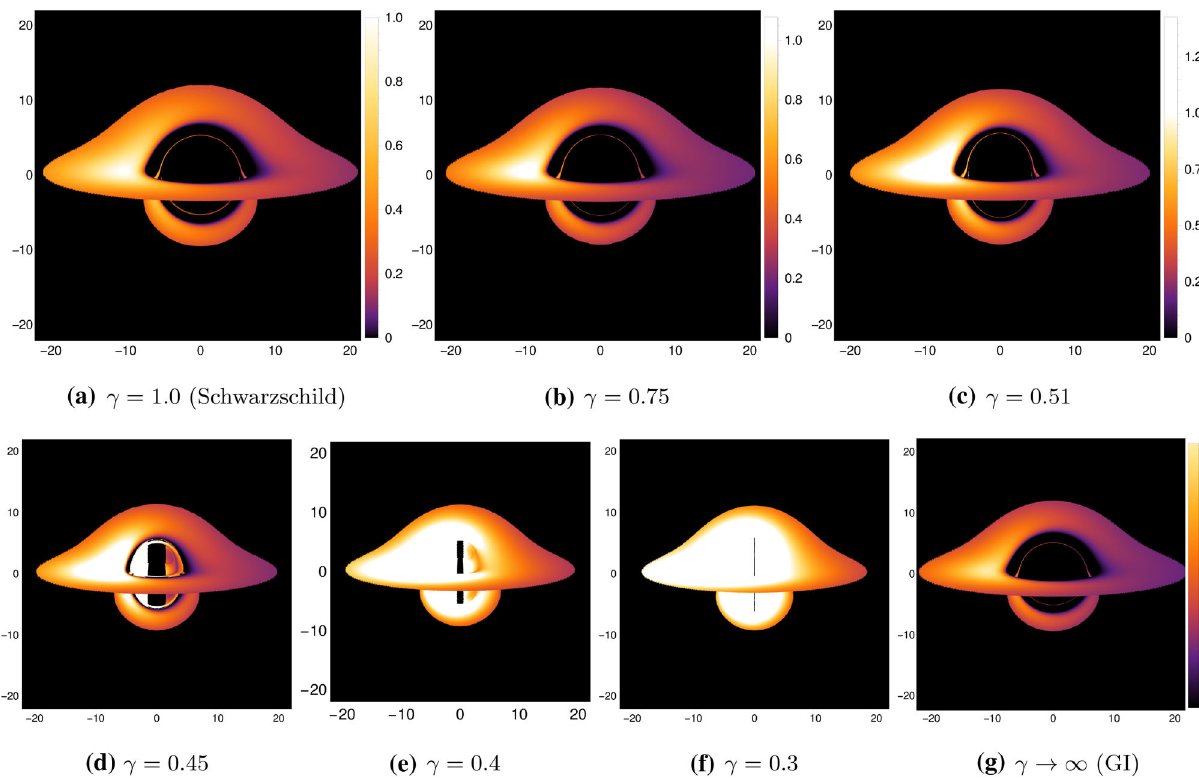
Fig. 8 The images of accretion disks in a Schwarzschild black hole and the γ -metric ( a – g ). See the text for the disk configurations for dif- ferent values of γ . The outer edge of the outer disk is at r = 20 M , and the observer’s inclination angle is θ o = 80 ◦ . The observer is placed at the radial coordinate r = 10 4 M , which corresponds effectively to the asymptotic infinity. In order to get rid of the parameters M and ˙ M , we have normalized the fluxes by the maximum flux observed for